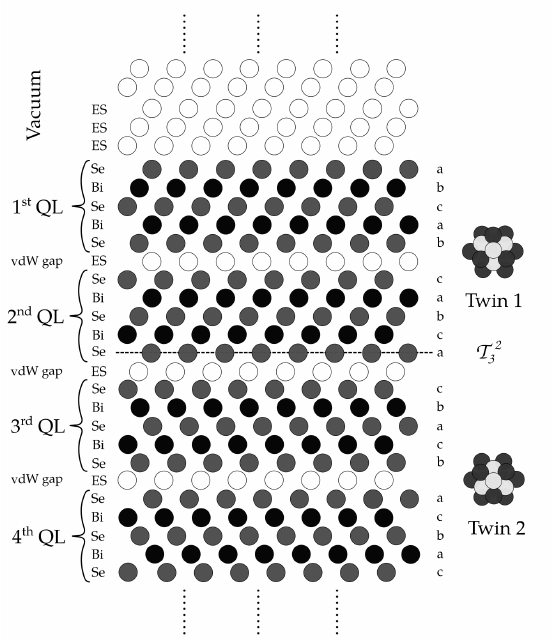
Figure 2. Layout of the simulated multilayer Bi 2 Se 3 structure including twin planes. Proportions of atoms are not realistic within this schematic figure. QL—quintuple layer, ES—empty sphere, T 2 plane between the second QL and the third